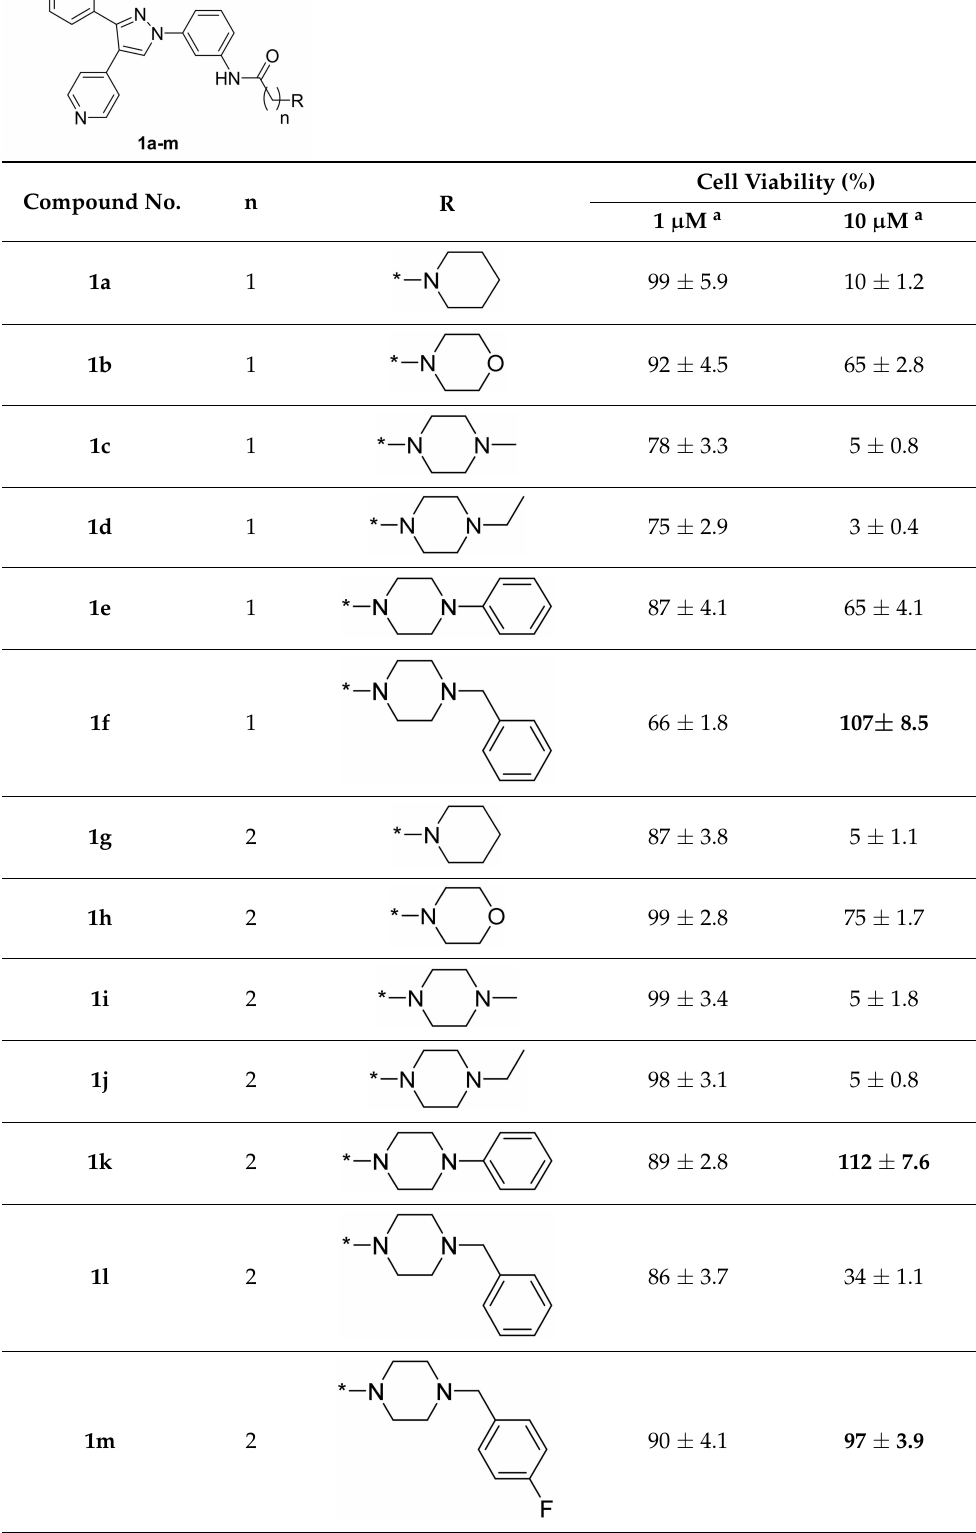
Table 1. Structures of compounds 1a – m and their cell viability results at 1 and 10 µ M concentrations against murine RAW 264.7